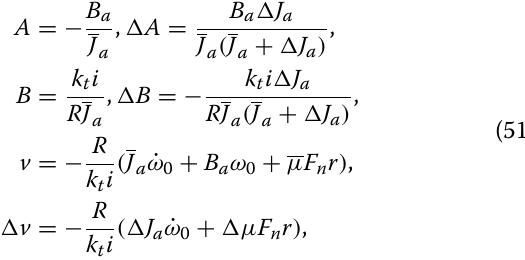
Figure 2 The wheel‑transmission‑motor subsystem